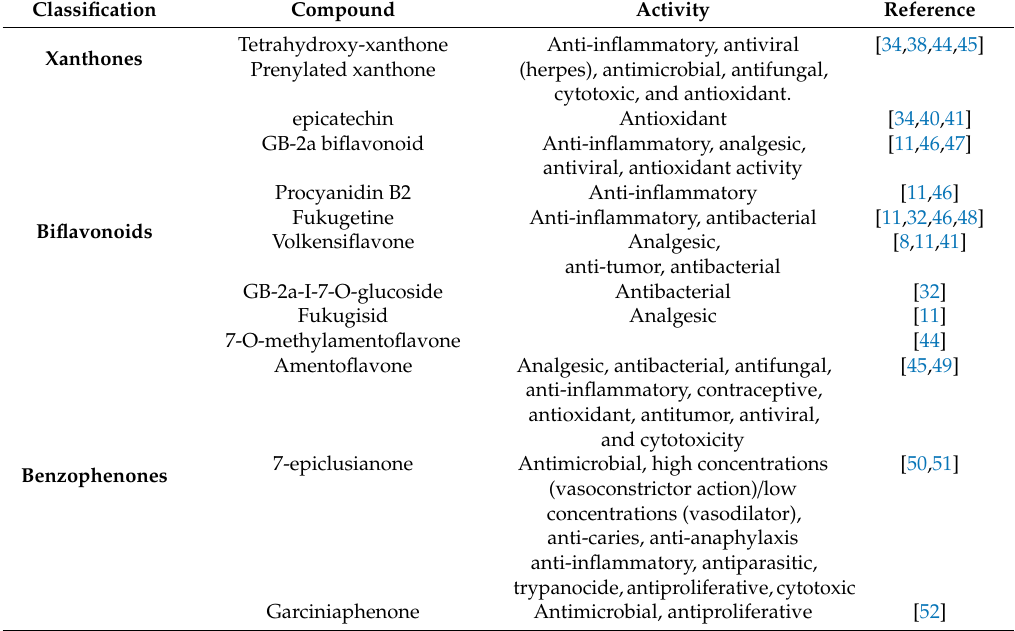
Table 6. Biological activities of compounds identified in the extracts of G. gardneriana leaves and fruits. Modes and their biological activities were already reported in the references cited for the species Garcinia